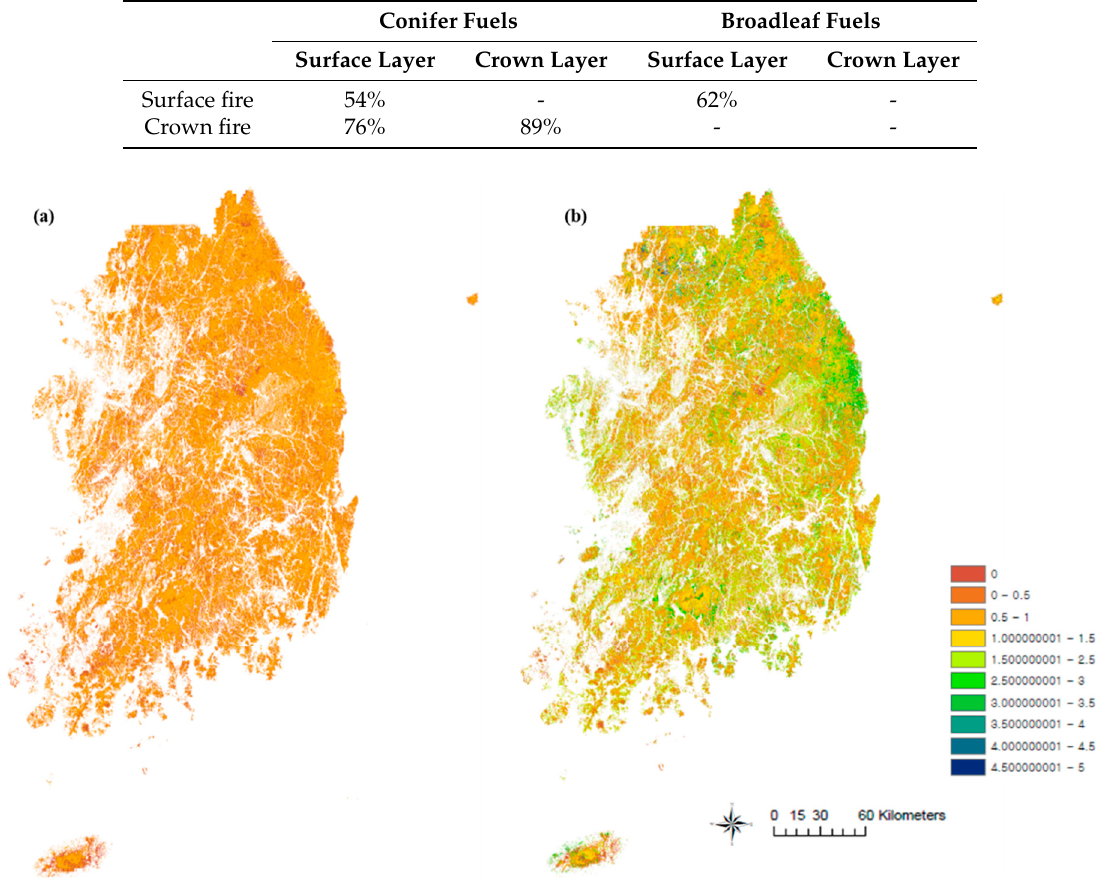
Table 1. Combustion efficiency for surface- and crown-fire carrying fuels.